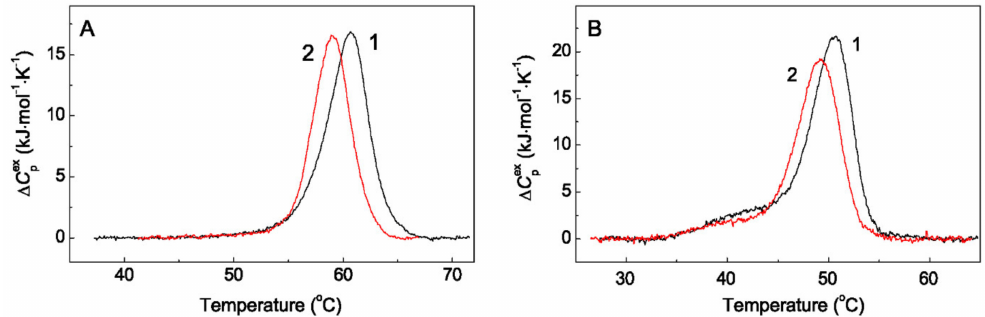
Figure 7. The e ff ect of Arg on thermal stability of protein chaperones. The temperature dependences of the excess heat capacity ( C p ) obtained by DSC ( A ) for HspB6 (1.2 mg / mL) and ( B ) for 14-3-3 ζ m (1 mg / mL) in the absence and in the presence of 0.1 M Arg (curves 1 and 2, respectively). The ionic strength in both cases was 0.15 M. The heating rate was 1 ◦ C / min.